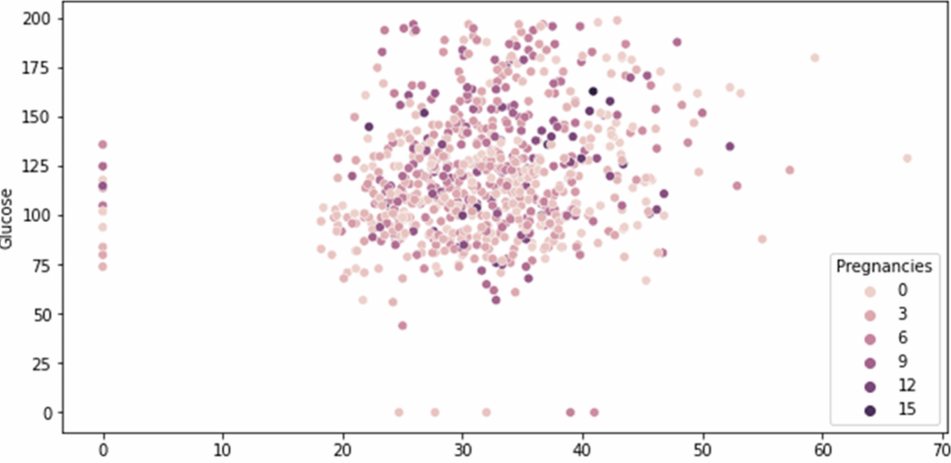
Figure 8. Visualizing glucose vs. BMI vs. pregnancies using scatter